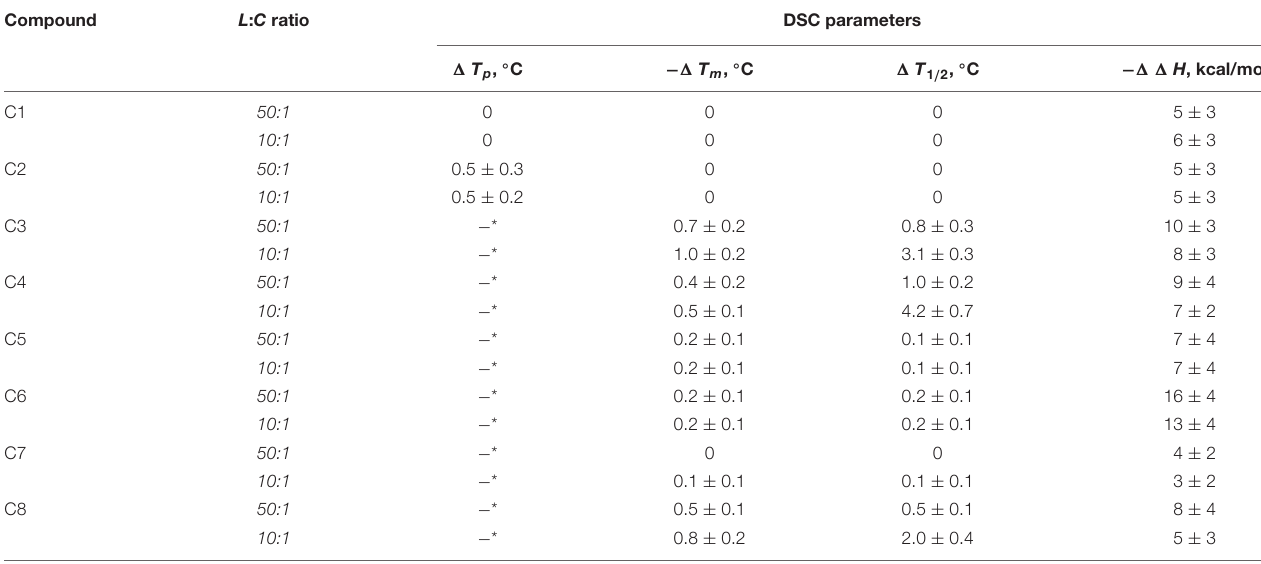
TABLE 4 | Parameters that characterize the thermotropic behavior of DPPC in the presence of 1,3-thiazine, 1,2,3,4-dithiadiazole, and thiohydrazide derivatives in liposome suspension at different lipid:compound ( L:C ) molar ratios. Compound